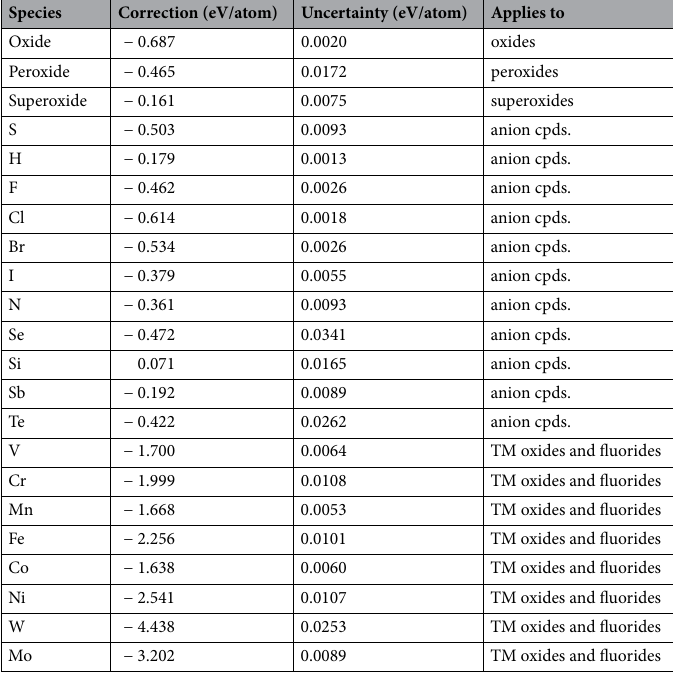
Table 1. Fitted energy corrections, uncertainties, and types of compounds to which each correction is applied. These are the correction values used in the Materials Project database at the time of publication (database version 2021.05.13). The corrections may be periodically refit in the future using the method described